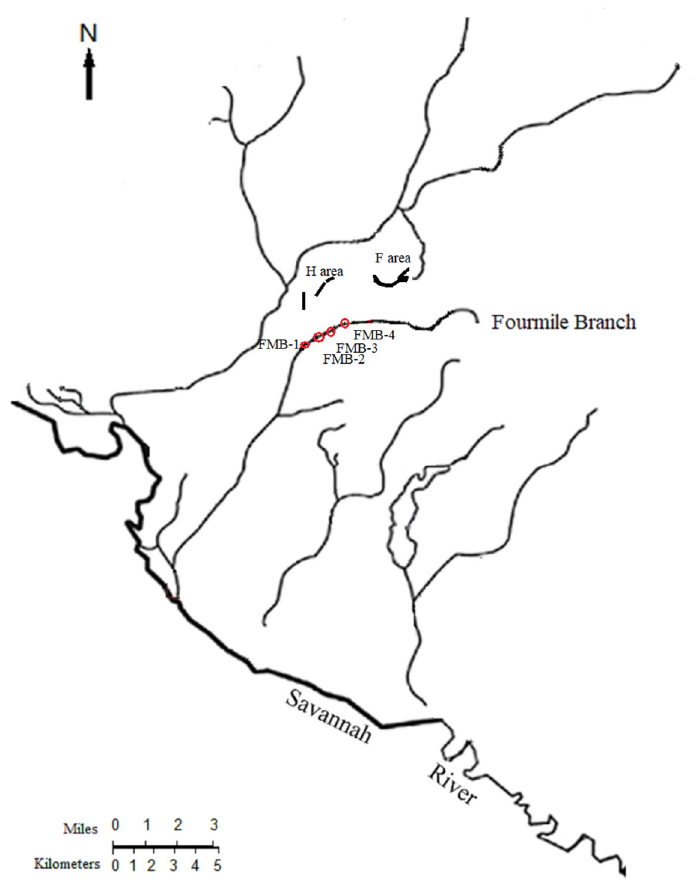
Figure 1. Maps of Fourmile Branch and Savannah River. The four sampling sites and the seepage basins along the Fourmile Branch are indicated in the map.